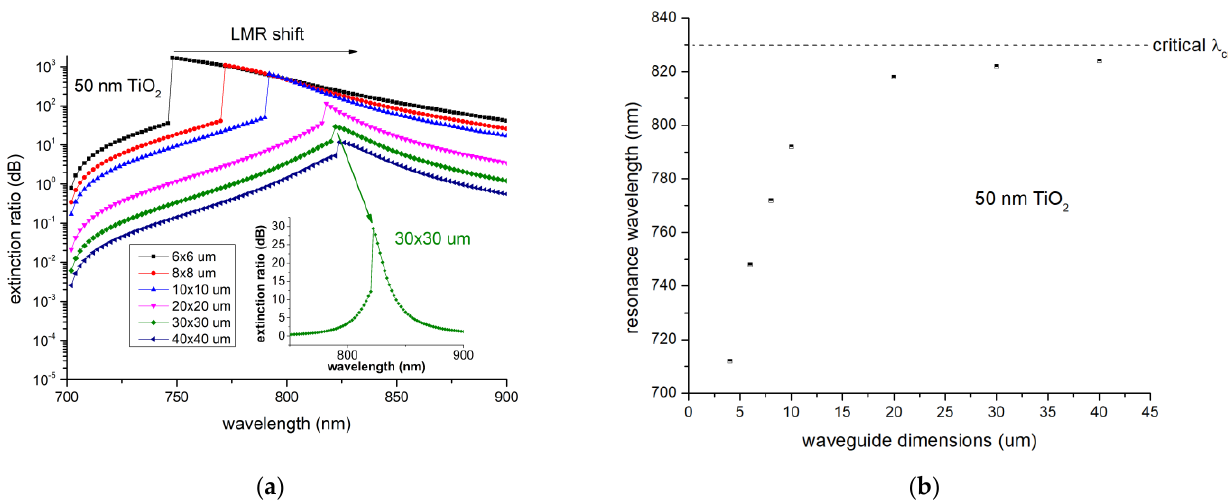
Figure 3. Effect of waveguide dimensions on the LMR effect: ( a ) extinction ratio spectra for different waveguide dimensions; ( b ) LMR wavelength depending on the dimensions of the waveguide.